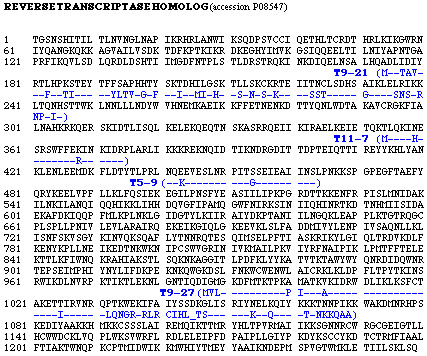
Four identified antigen sequences with partial homology to reverse transcriptase homolog. Peptide sequence is reported in single-letter code. Identical amino acids in the selected clones and reverse transcriptase homolog are represented by a dash. These clones were isolated from libraries of different origin. Clones T9-21 and T9-27, isolated from solid tumor library, had significantly high frequency of reactivity with sera from breast cancer patients.